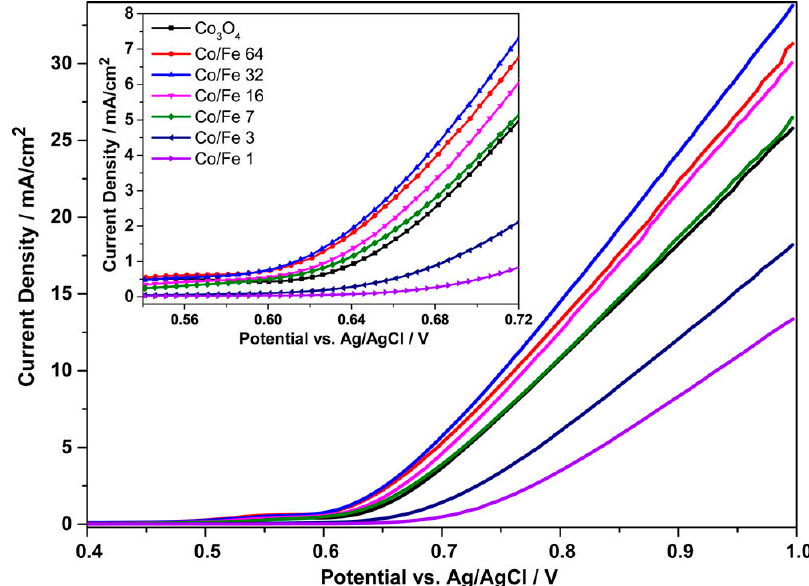
Figure 4. Oxygen evolution currents of Co 3 O 4 and Fe-Co 3 O 4 with various Co/Fe atomic ratios (64, 32, 16, 7, 3, and 1) [39]. Reprinted with a permission of © 2014 American Chemical Society. Fe-mCo 3 O 4 samples with ratios Co/Fe = 32 and Co/Fe = 64 had the highest catalytic activity and